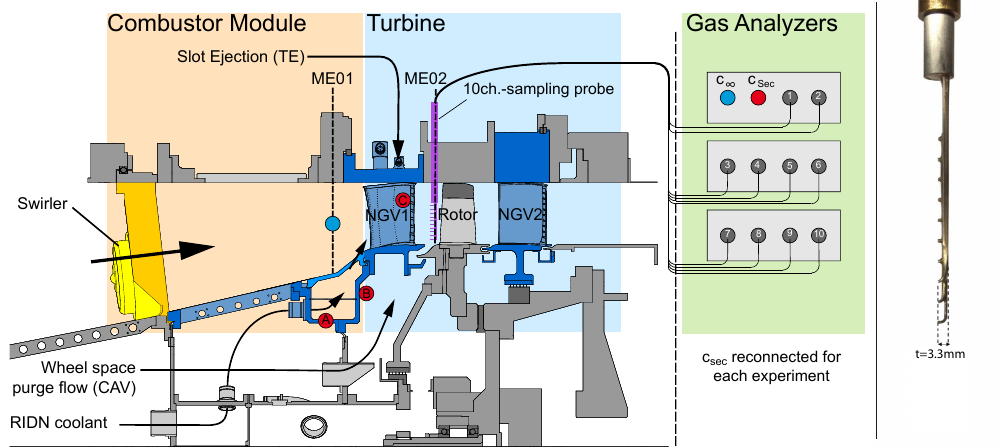
Figure 2. Measurement locations for flow tracing. The reference measurement position in the main flow (blue) and secondary flow (red) are illustrated. The 10-channel sampling probe head is shown on the